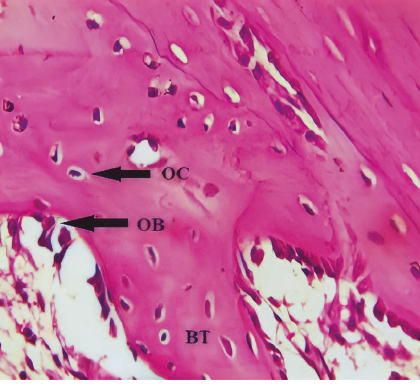
Figure 3: A view of the defect site in the GS/PSO group shows OB, OC, and bone trabeculae (BT) after 2-weeks. H&E x40.